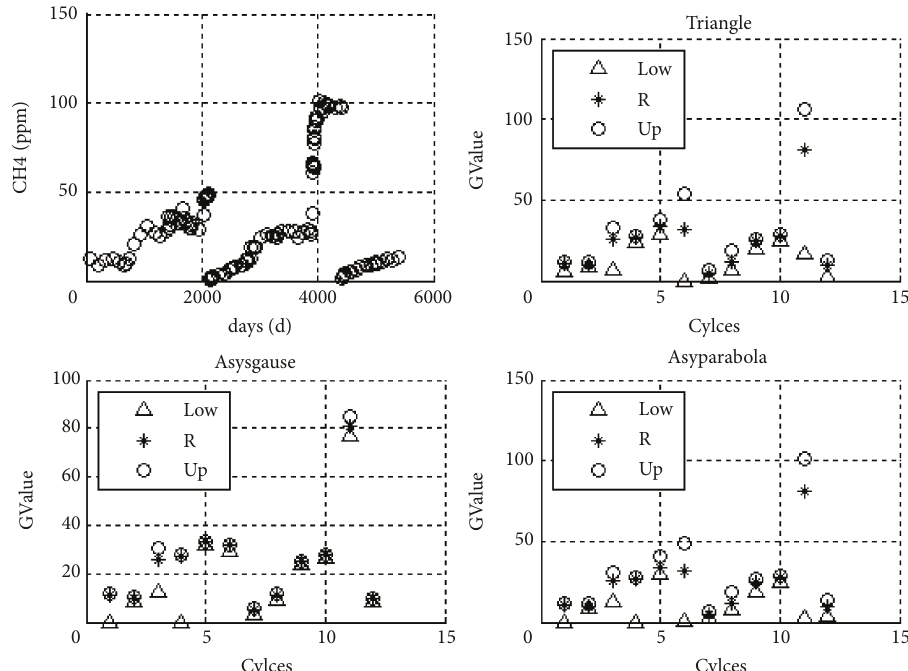
Figure 4: CH 4 concentration and information granulated by a refueling cycle as time window with three different membership functions.